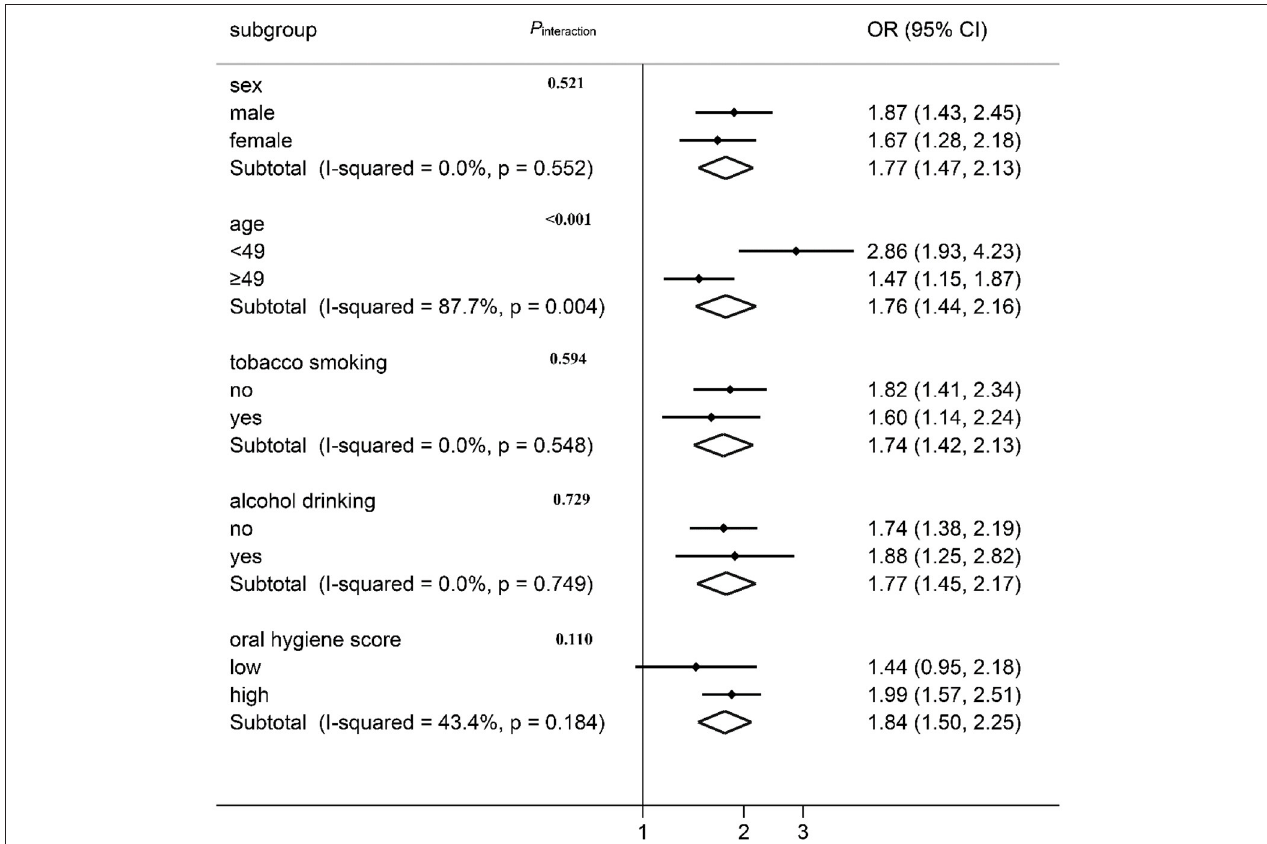
FIGURE 3 | Association between “SFA” pattern and oral cancer risk by stratification analysis.